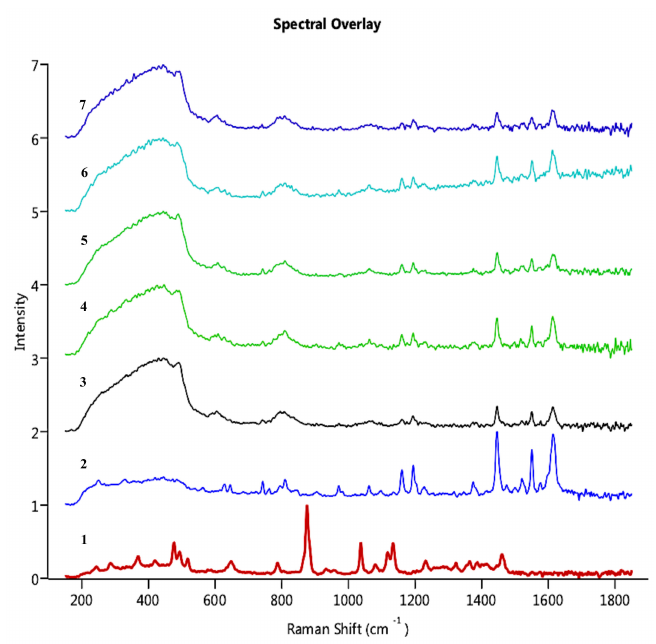
Figure 6. Overlay of Raman Spectra captured for particles in CEL_NCSD dispersion; the Spectra have been compared for (1) MAN, (2) CEL and selected particles in the dispersion (3) Particle 587, (4) Particle 9137, (5) Particle 23,642, (6) Particle 23,884 and (7) Particle 30,630. Table 3. Raman Correlation Scores for selected particles / particles of interest in the dispersion. Particles of Interest Raman Correlation Score (with Pure